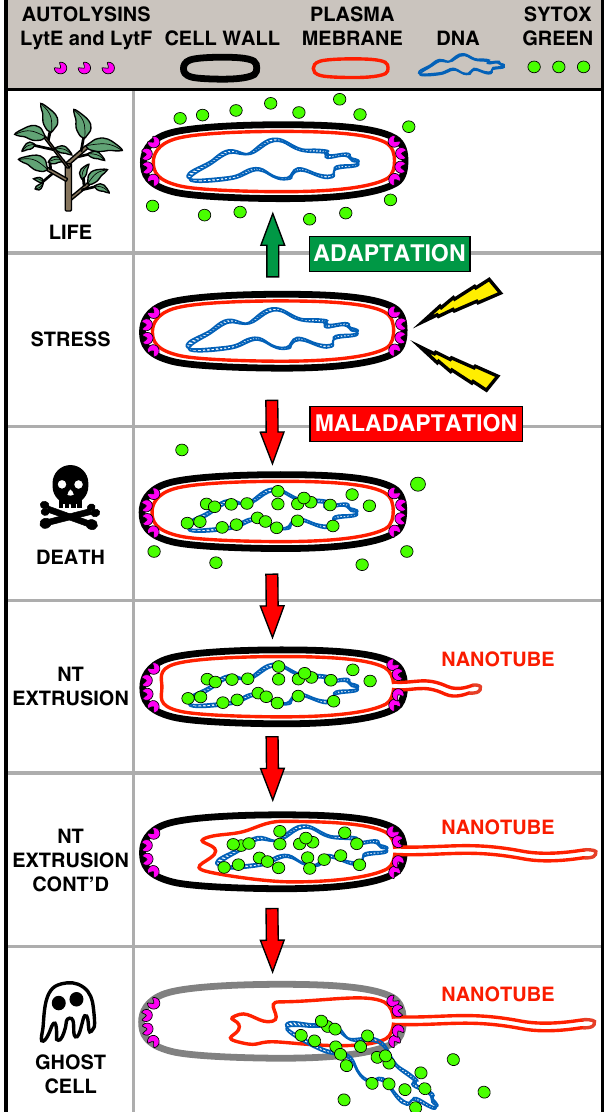
Fig. 6 Model of NT formation. The fi gure depicts NT formation: stressed cells (e.g., pressure, ampicillin treatment) either adapt or when the stress is too severe, die. During cell death, the plasma membrane becomes compromised and membranous tubular structures are extruded from dying cells. Autolysins LytE and LytF that localize at the cell poles weaken the cell wall and facilitate NT extrusion. Eventually, the cell contents are emptied and a hollow husk — the ghost cell — remains. No physiological role for these NTs has been detected.